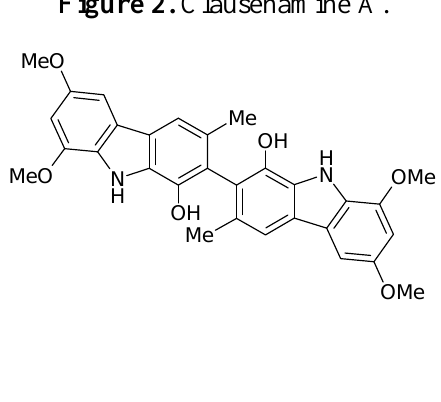
Figure 2. Clausenamine